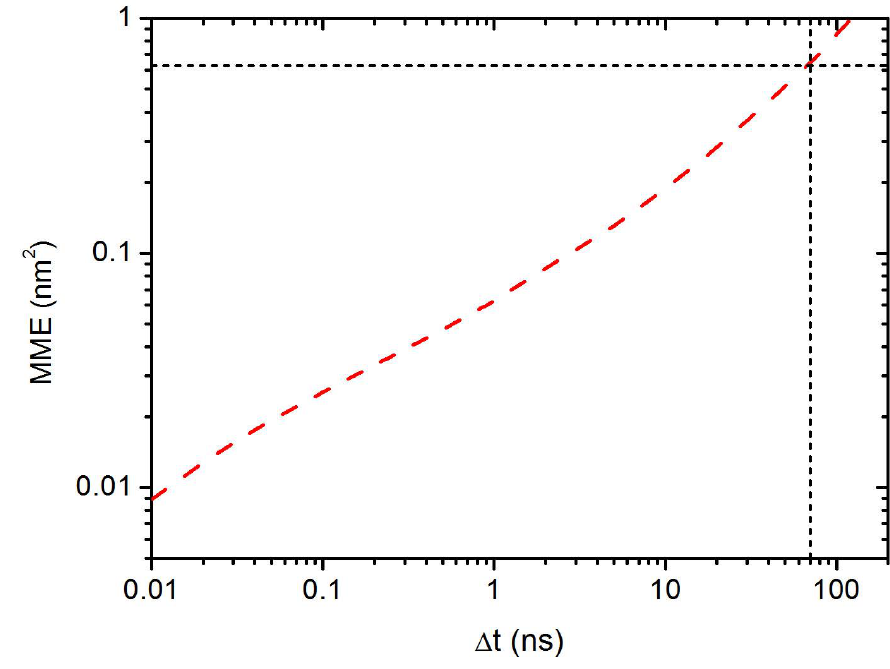
Figure 10. The second moment of MME as a function of time ∆ t for C 60 in PS